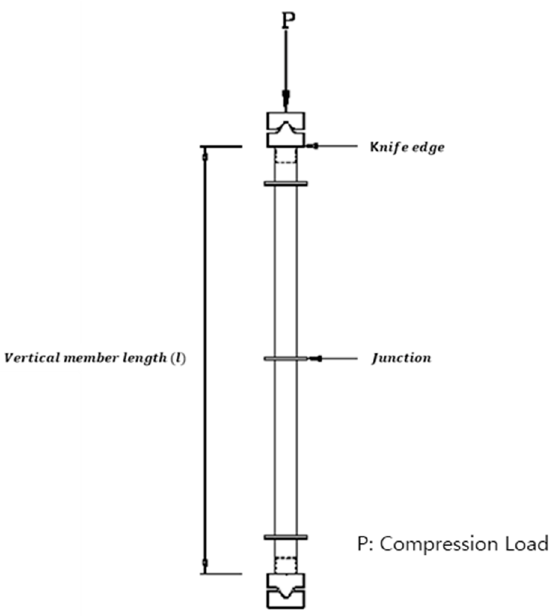
Figure 1. Compression load test of a vertical member [36].